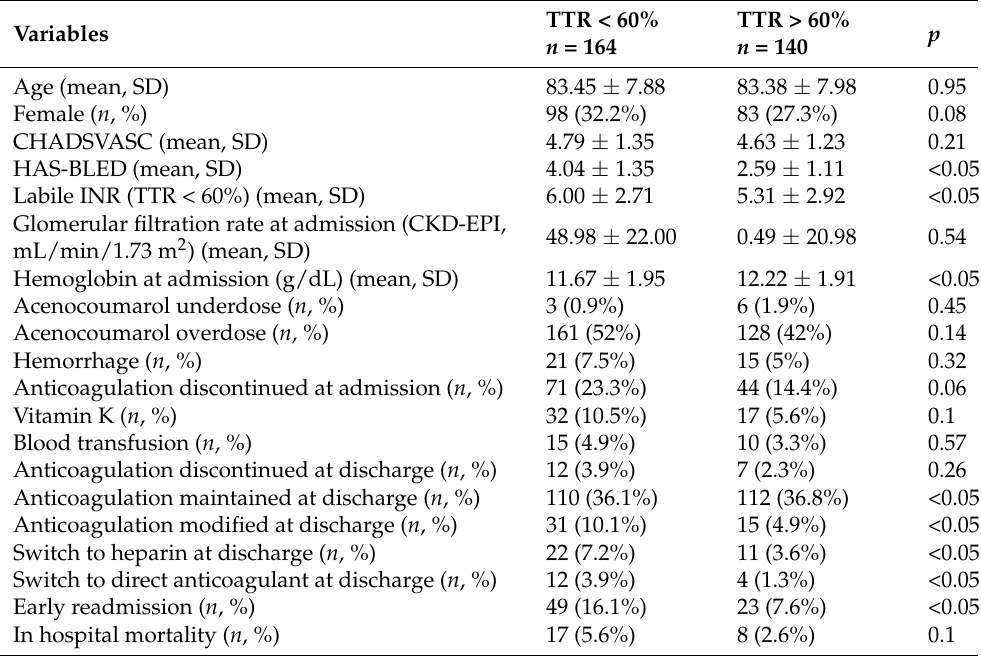
Table 2. Bivariate analysis of patients with HF, adverse reaction to anticoagulation, and therapeutic range (TTR) higher or lower than 60%.